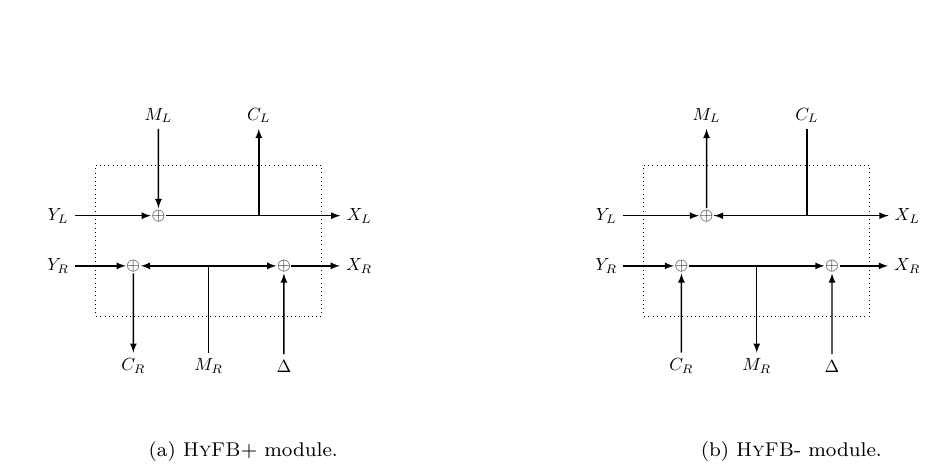
Figure 5: HyFB module of HyENA for full data blocks. The number of XOR count is equals to 3 n/ 2.